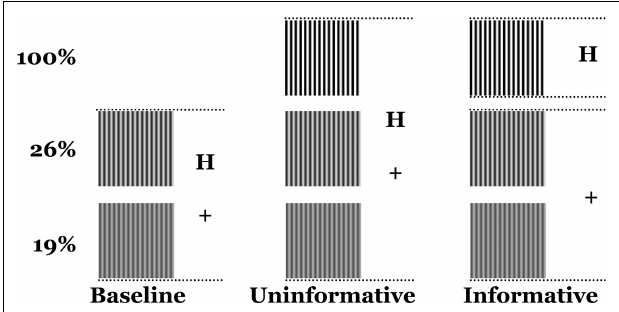
FIGURE 2 | Experimental conditions. Baseline: only the two low-contrast gratings appear and the cues are unpredictive. Uninformative: all three gratings appear and the cues are unpredictive. Informative: all three gratings appear, “ + ” predicts low-contrast gratings, “H” predicts the high-contrast grating.